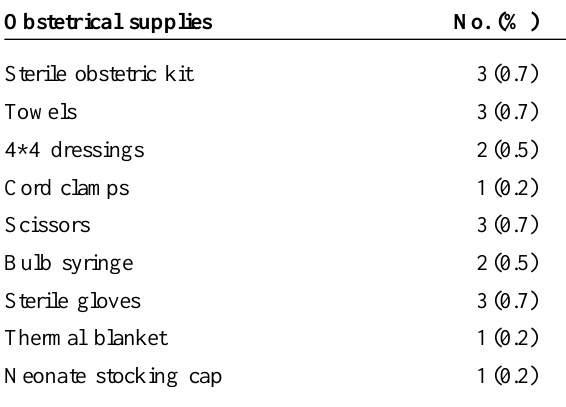
Table 6. Obstetrical supplies available for a basic life support (BLS) ambulance (n=409)